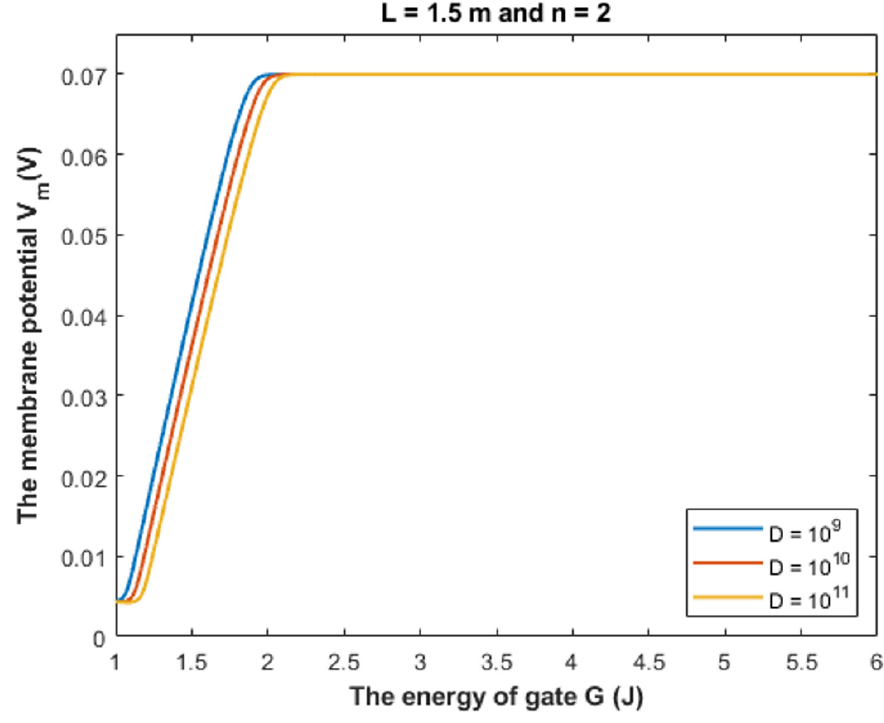
Figure 16. The figure represents the influence of the energy of gate G on the resting membrane potential according to different values of receptors density and according to the setting values above the figure.